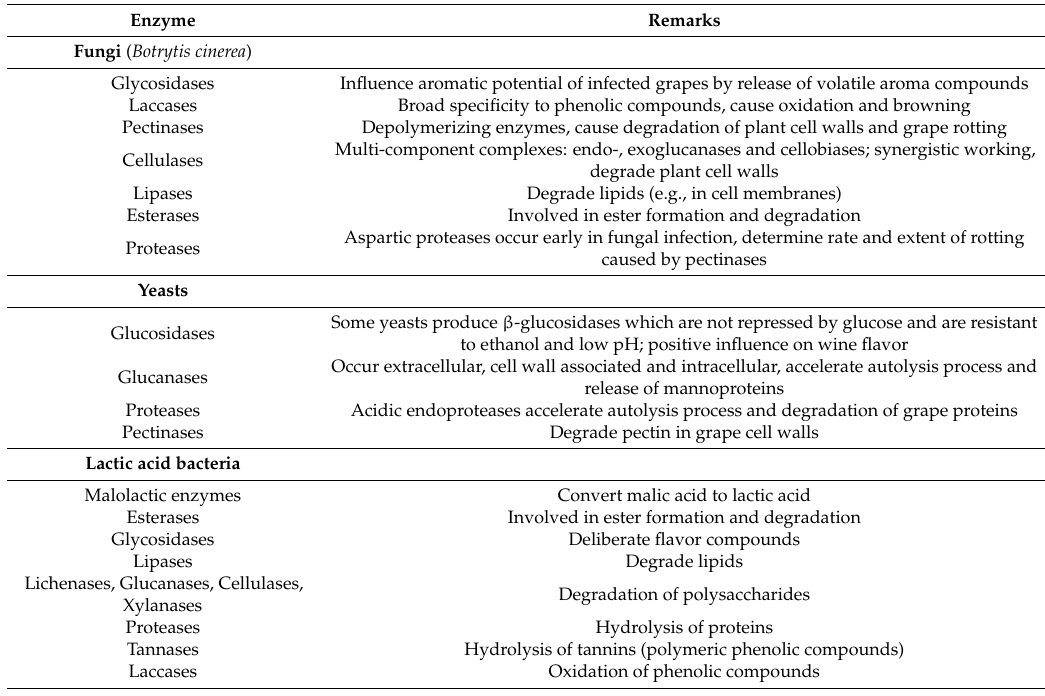
Table 2. Microbial enzymes with relevance for